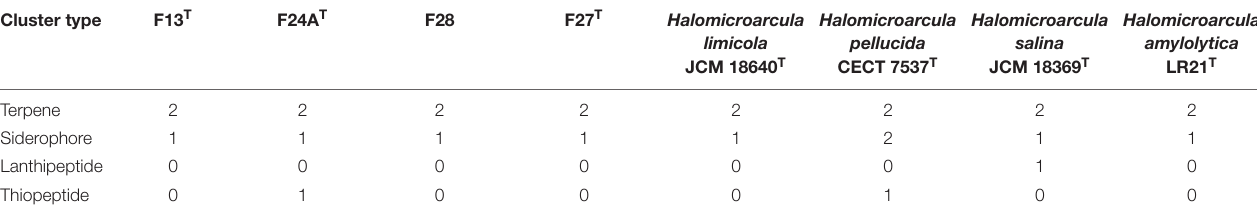
TABLE 3 | Number of genetic clusters involved in the biosynthesis of secondary metabolites determined in the genomes of strains F13 T , F24A T , F28, F27 T , and the type strains of species of Halomicroarcula . Cluster